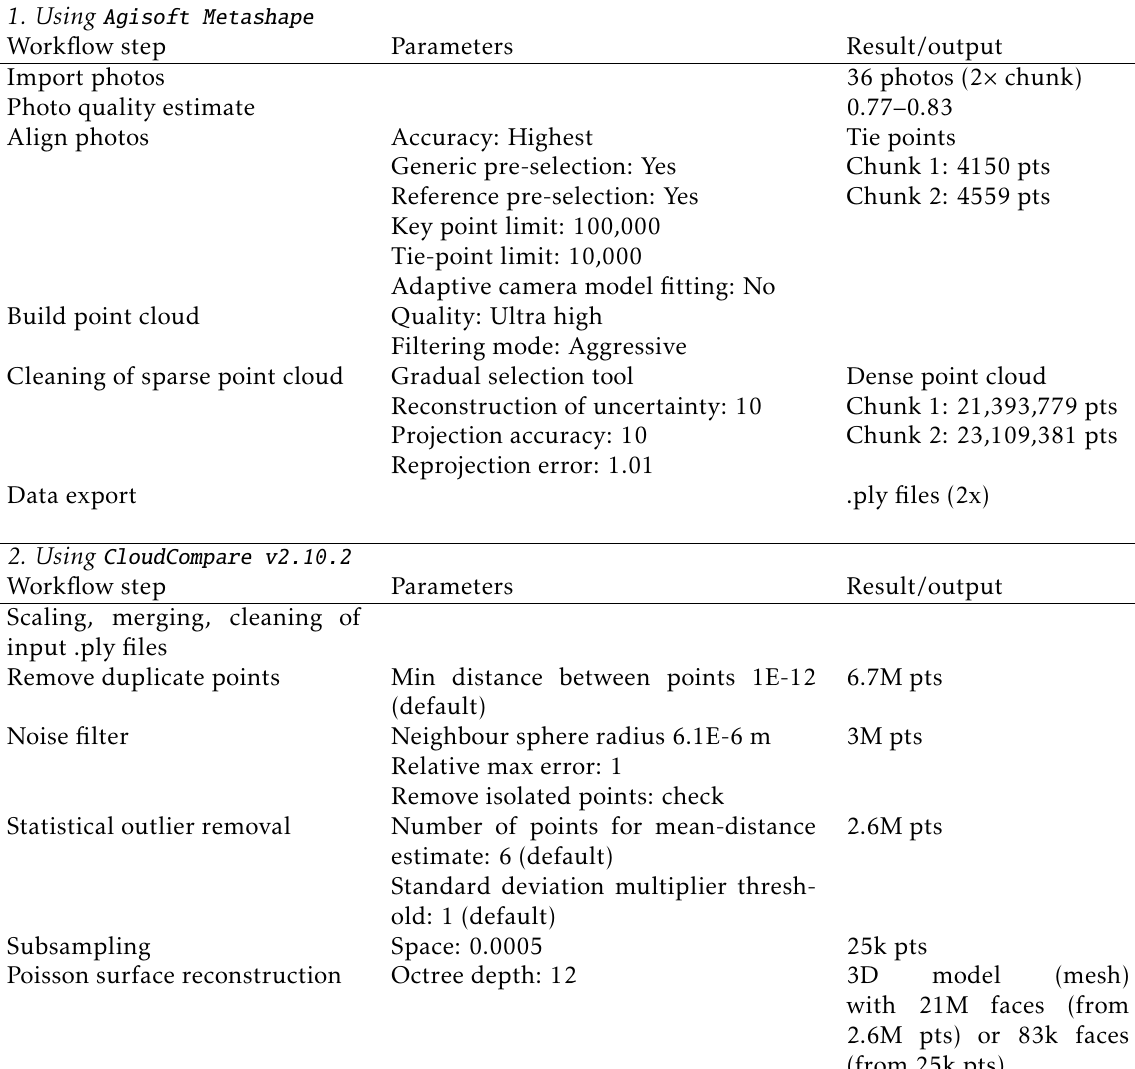
Table A1: Workflow for volume analysis using collections of